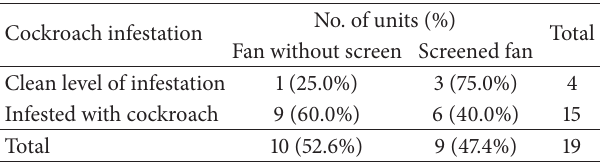
Table 5: Frequency of screened fans at the surveyed